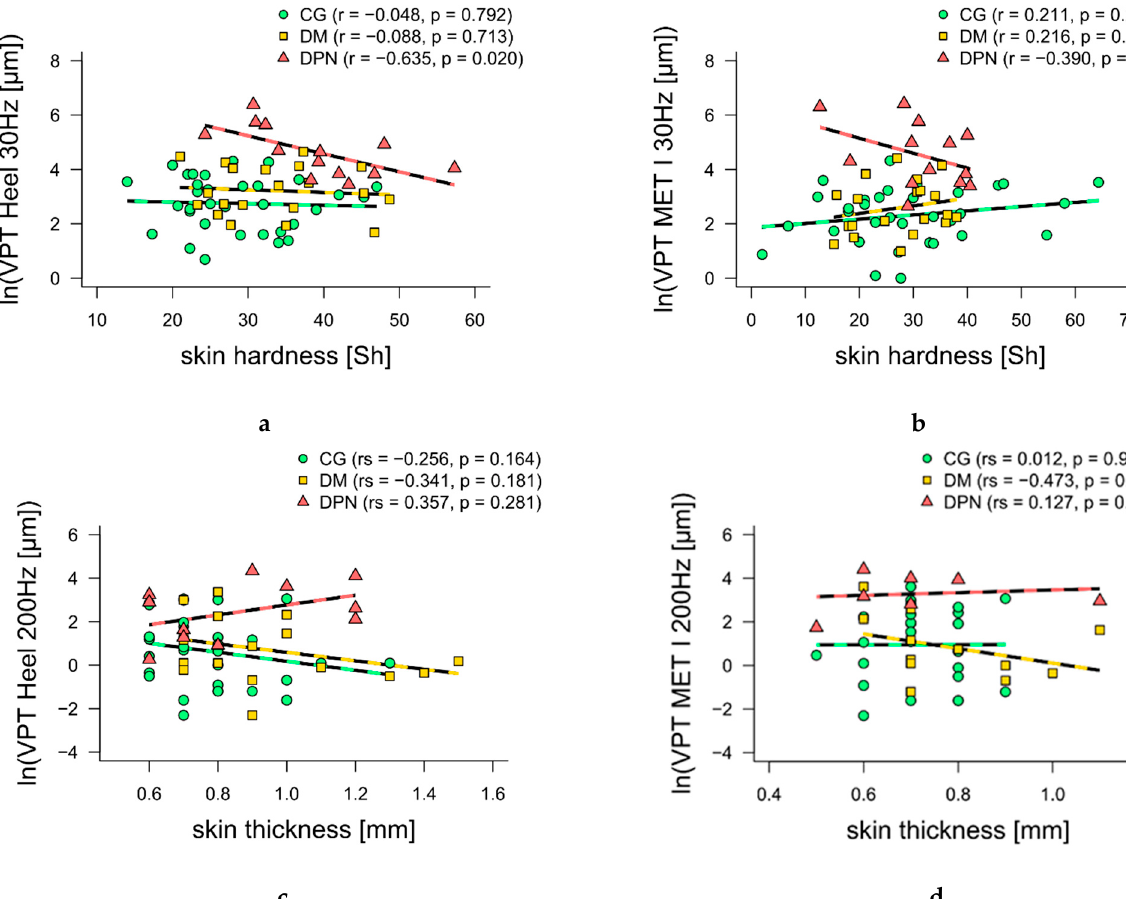
Figure 3. Spearman’s rank-order (rs) and Pearson’s product-moment (r) correlations between vibration perception thresholds (VPT) and mechanical skin properties. ( a , b ) Scatter plot of skin hardness versus VPT at 30 Hz at the heel and first metatarsal head (MET I) for control group (CG, green), individuals with diabetes without diabetic neuropathy (DM, yellow) and individuals with diabetes with diabetic neuropathy (DPN, red). ( c , d ) Scatter plots of skin hardness versus VPT at 200 Hz at heel and first metatarsal head (MET I) for control group (CG, green), individuals with diabetes without diabetic neuropathy (DM, yellow) and individuals with diabetes with diabetic neuropathy (DPN, red).